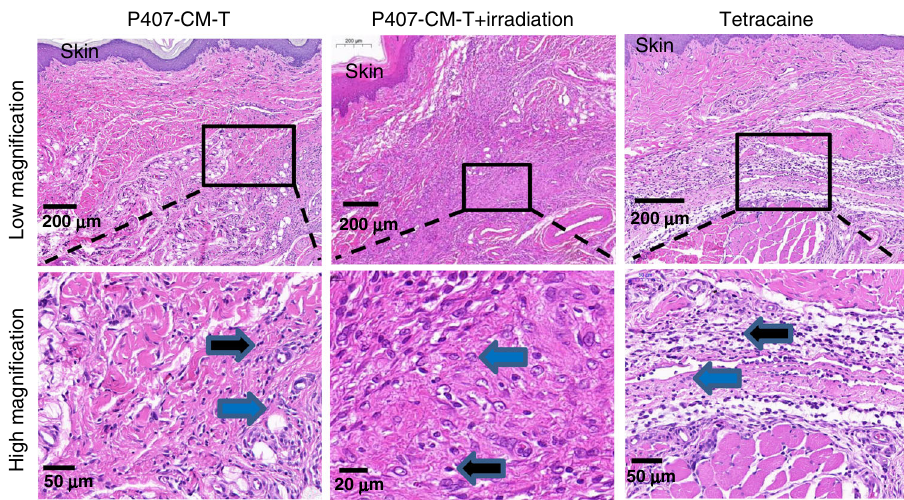
Fig. 6 Tissue reaction to rat footpad injections on day 4 after injection of P407-CM-T (with/without irradiation) or tetracaine. In fl ammation at the injection site was characterized by lymphocytes (black arrows) and macrophages (blue arrows) extending from the sub-epidermal layers into the deeper muscular layer. Panels on bottom (scale bar: 50 μ m) are magni fi ed views of the outlined sections in the panels on the top (scale bar: 200 μ m). Data are representative of four animals in each